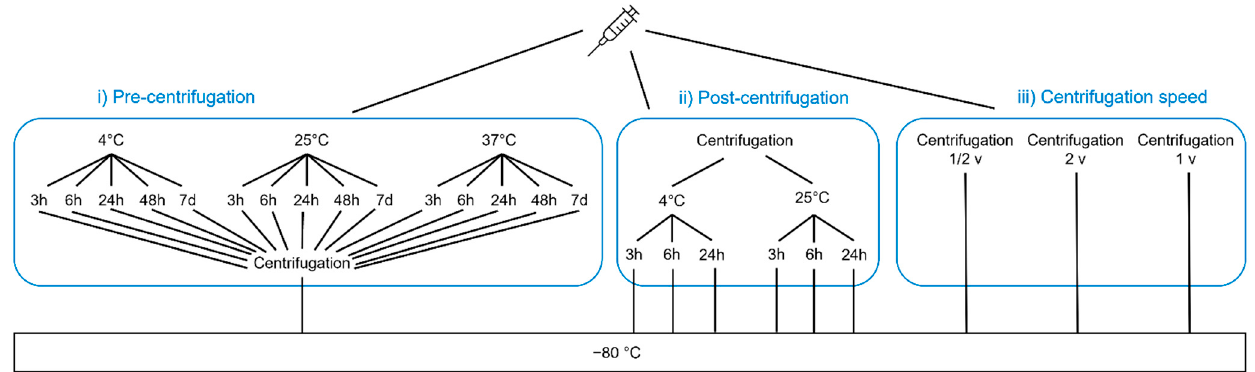
Figure 1. Workflow of the short-term stability experiment. The chart summarizes all the different conditions tested in the short-term stability experiments. The blood is collected all at the same time and split into aliquots for downstream processing. The left side of the graphic (i) includes all temperature and time points before centrifugation, whereas those regarding after centrifugation conditions can be found in the middle (ii). The variation in centrifugation speed is positioned on the right. The control sample, centrifuged and frozen immediately is located on the right end of the figure. v, velocity